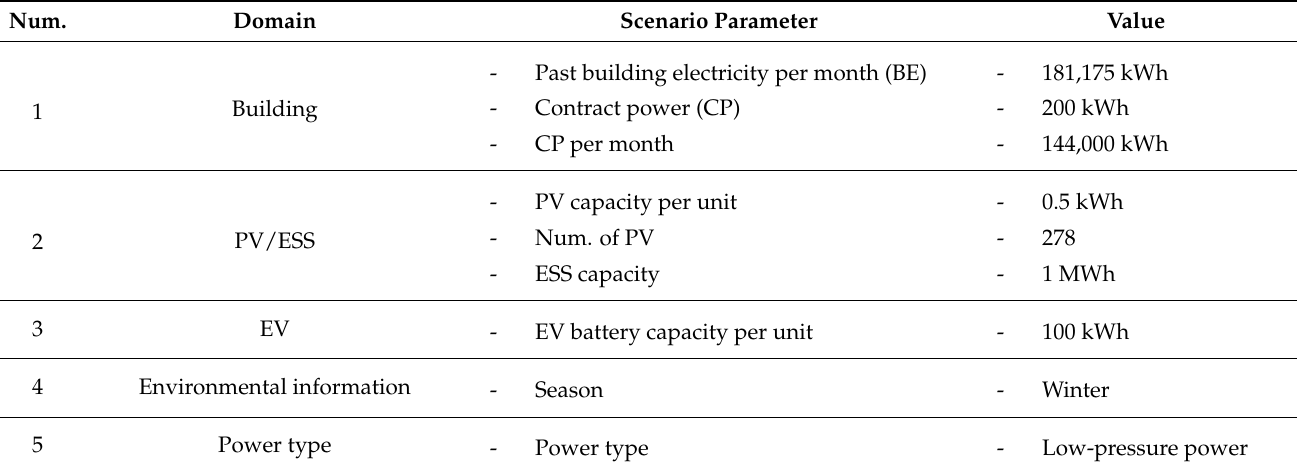
Table 4. Value Settings for The Proposed System Scenario Simulation.